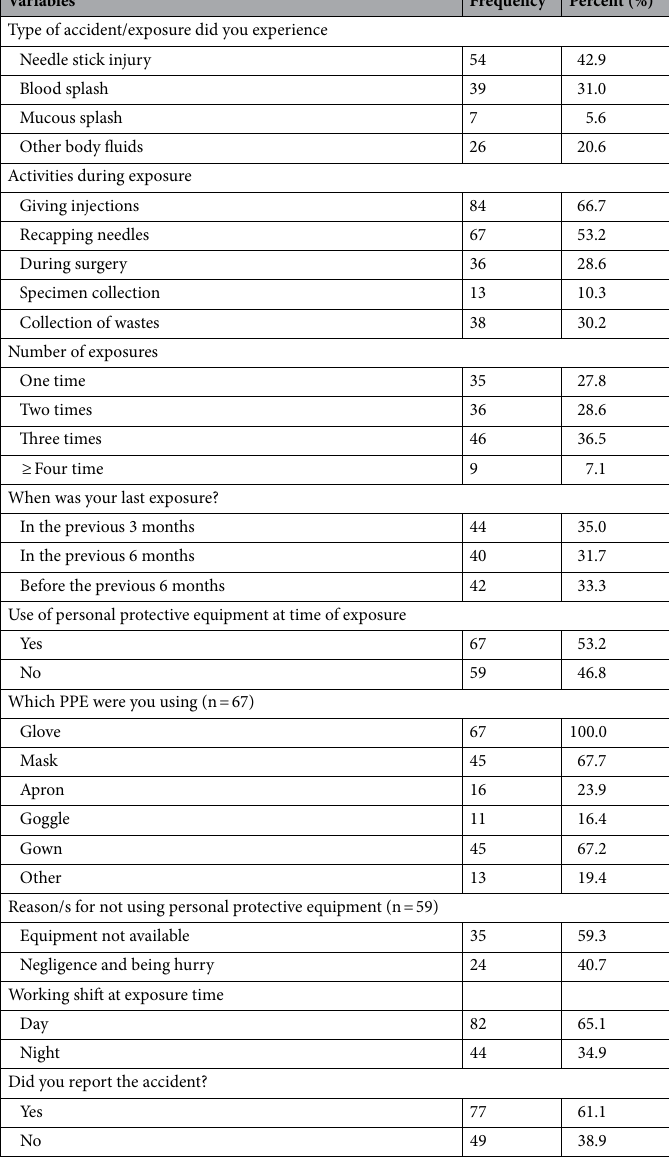
Table 2. Occupational exposure of healthcare workers (n = 126) to HIV in St. Peter’s specialized hospital in Addis Ababa, Ethiopia, April